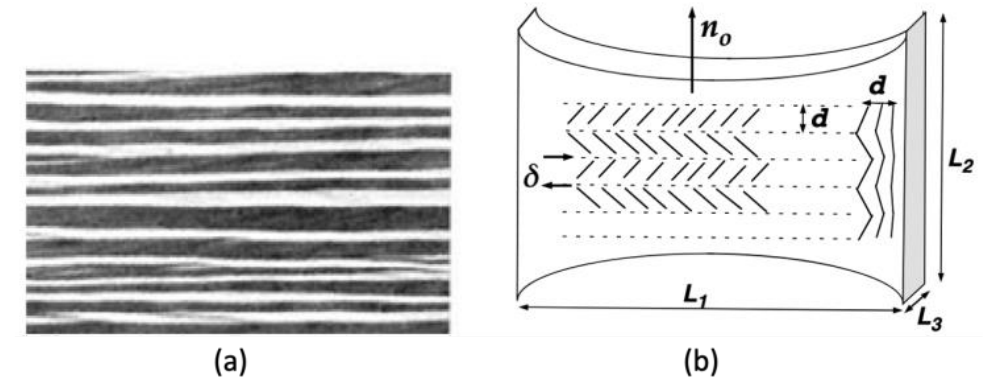
Figure 3. Stretch-induced rotation of monodomain LCN: ( a ) the stripe domain texture; ( b ) the scheme of experimental geometry where stretch is imposed to the direction perpendicular to n 0 (Adapted with permission from Ref. [29]. 1996, Kenji Urayama et al.).